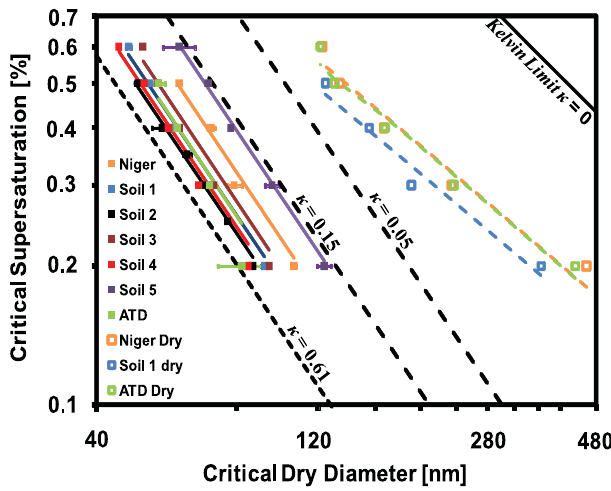
Fig. 2. CCN activation curves for different dust types considered in this study. Solid symbols refer to wet generated CCN activity and solid lines show κ -KT fits. Open symbols refer to dry gener- ated CCN activity and dashed line are FHH adsorption activation fits (Data obtained from Kumar et al., 2011). Also shown in black dashed lines are κ -KT lines.